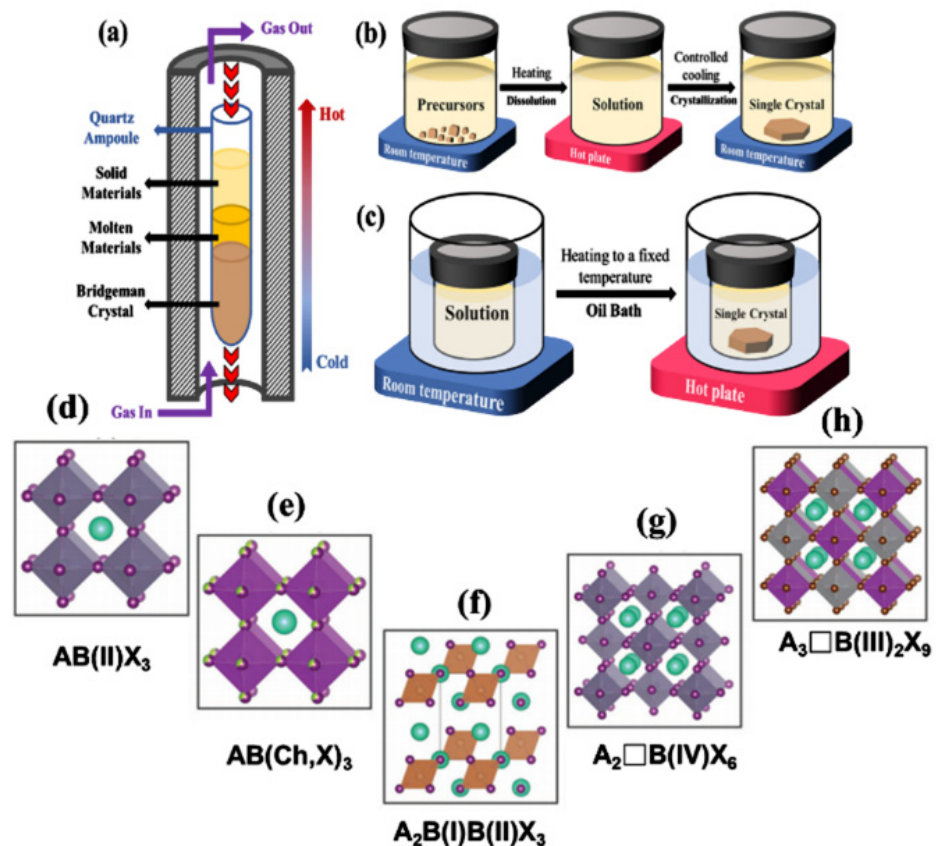
Figure 1. Schematic diagrams of synthesis methods of LFPSCs. ( a ) Bridgeman method. ( b ) Cooling-induced crystallization method. ( c ) Inverse temperature crystallization. ( d – h ) Typical crystal structures of LFPSCs. Reprinted (adapted) with permission from Reference 12. Copyright 2020 Elsevier Ltd. Reprinted (adapted) with permission from Reference [22]. Copyright 2021 American Chemical